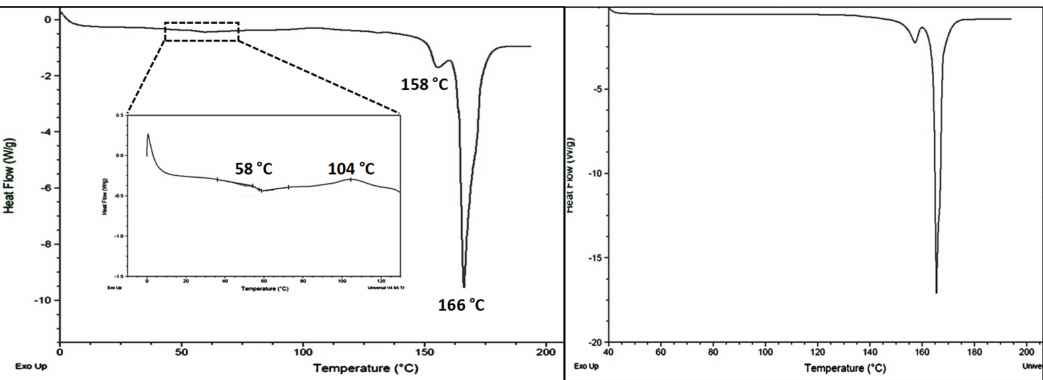
Figure 2. Di ff erential scanning calorimetry (DSC) of unannealed and annealed CEL_NCSD samples. The unannealed sample showed the glass transition ( T g) of CEL at 58 ◦ C followed by recrystallization temperature ( T c) at 104 ◦ C. Thereafter, the melting of CEL and Mannitol at 158 ◦ C and 166 ◦ C was observed, respectively. The annealed sample showed the melting of CEL at 158 ◦ C and that of Mannitol at 166 ◦